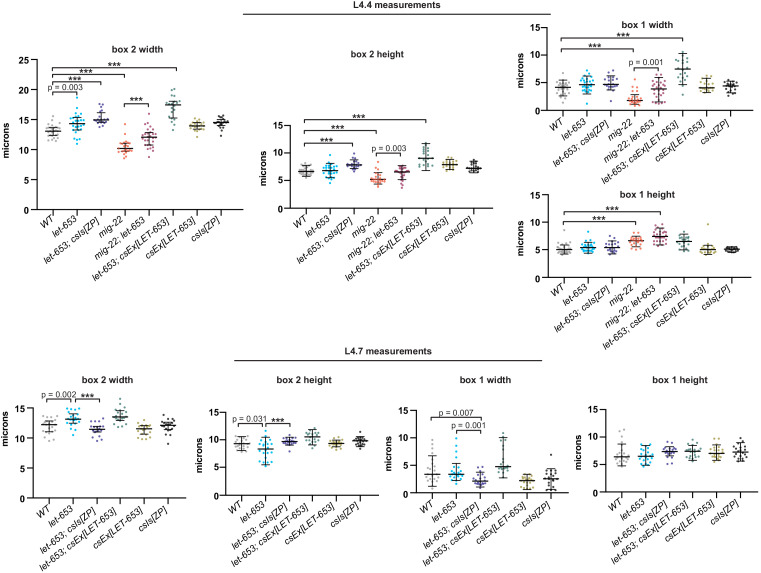
Measurements of let-653, mig-22, and LET-653+ vulvas Lumen dimensions at the L4.4 and L4.7 stages were quantified as in Figures 8 and 11.***p<0.0001, Mann–Whitney U test. All p values between 0.01 and 0.0001 are reported. p values above 0.01 are not indicated. All measurements were performed by a researcher blinded to genotype. let-653 mutants had approximately wild-type vulvas at L4.4 stage but slightly misshapen vulvas by L4.7 stage. Overexpression of LET-653 caused expanded vulvas in a let-653 mutant background, but not in a WT background, possibly due to lower expression levels.